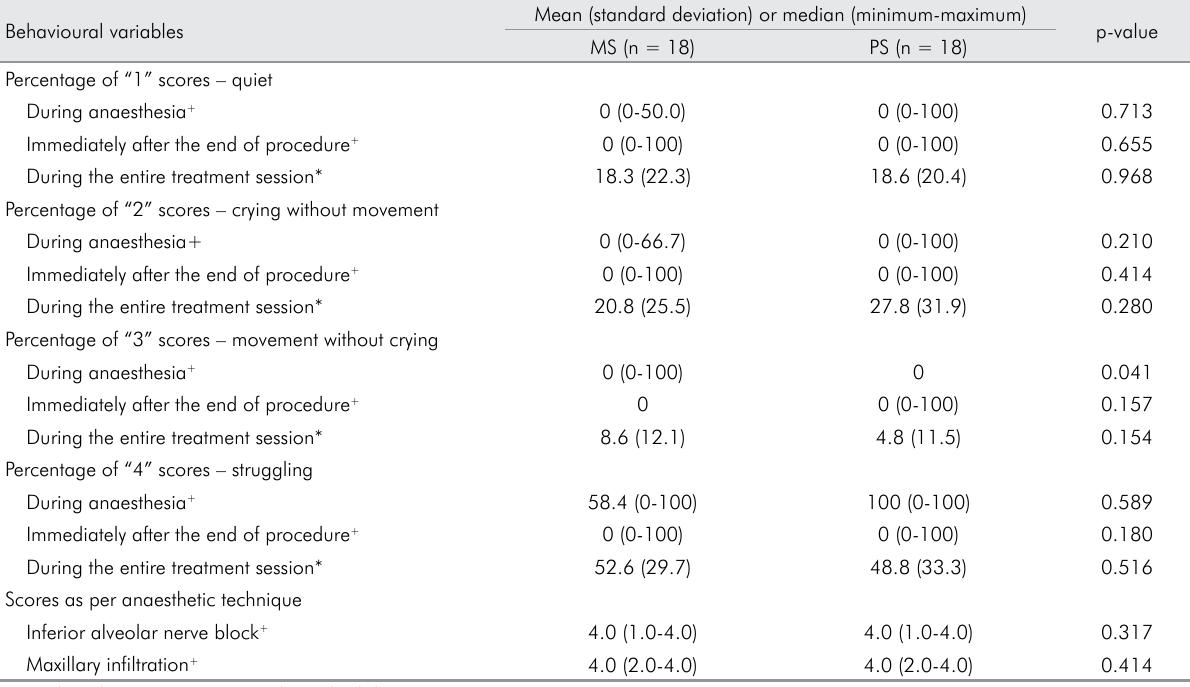
Table 2. Children’s behaviour during dental treatment under midazolam sedation (MS) or placebo (PS). Behavioural variables